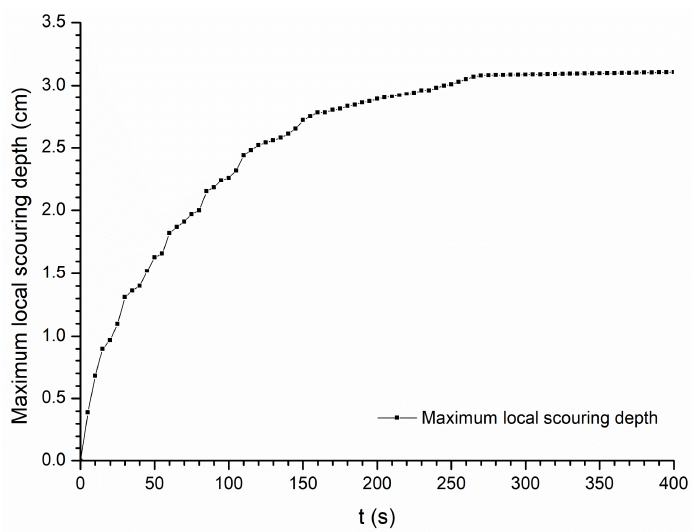
Figure 8. The maximum local scouring depth of Case 1 every 10 s.